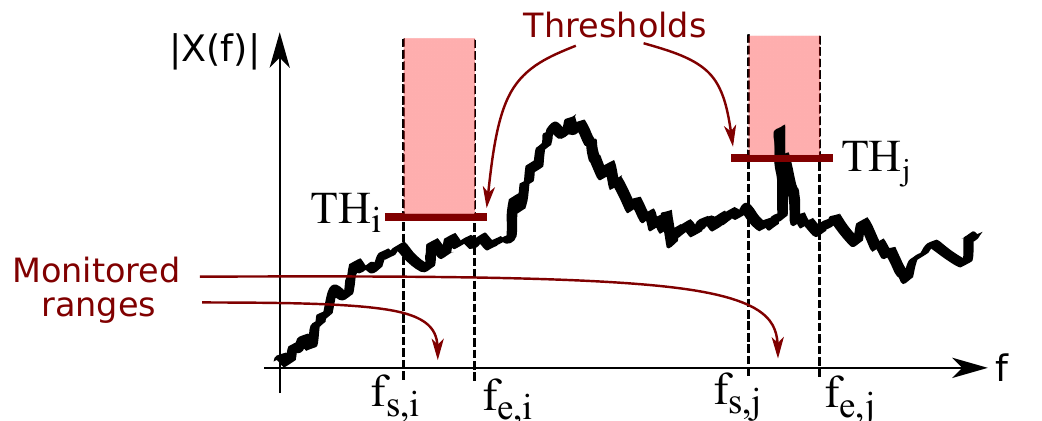
Figure 4. The i-th and the j-th range are shown, alongside their thresholds ( TH i , TH j ) and frequency intervals. In such a case, a fault is detected in the j-th range.